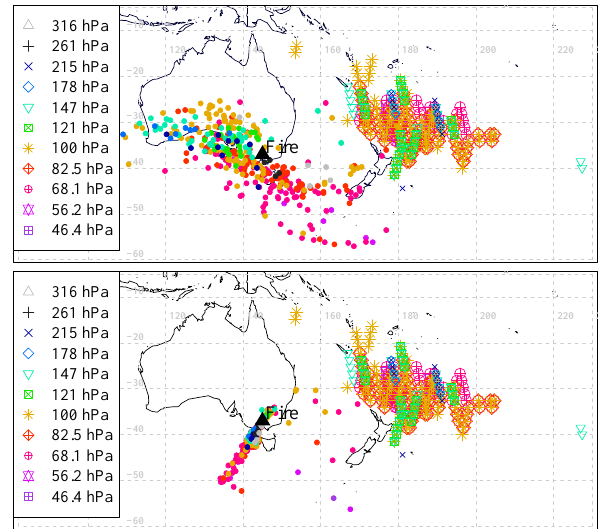
Fig. 10. Back trajectories run from MLS measurement locations with elevated CO levels for the ten days after the fire. The symbols in the legend show the locations of the MLS measurements. The filled circles show the trajectory location at 09:00UTC on 7 Febru- ary (upper map: examples are shown as filled circles in Fig. 9) and at the time of their closest pass to the fire region (lower map: exam- ples are shown as triangles in Fig.